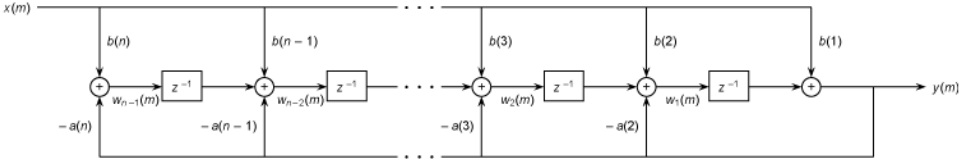
Figure 7. Representation of rational transfer function using its direct-form II transposed implementa- tion [33].